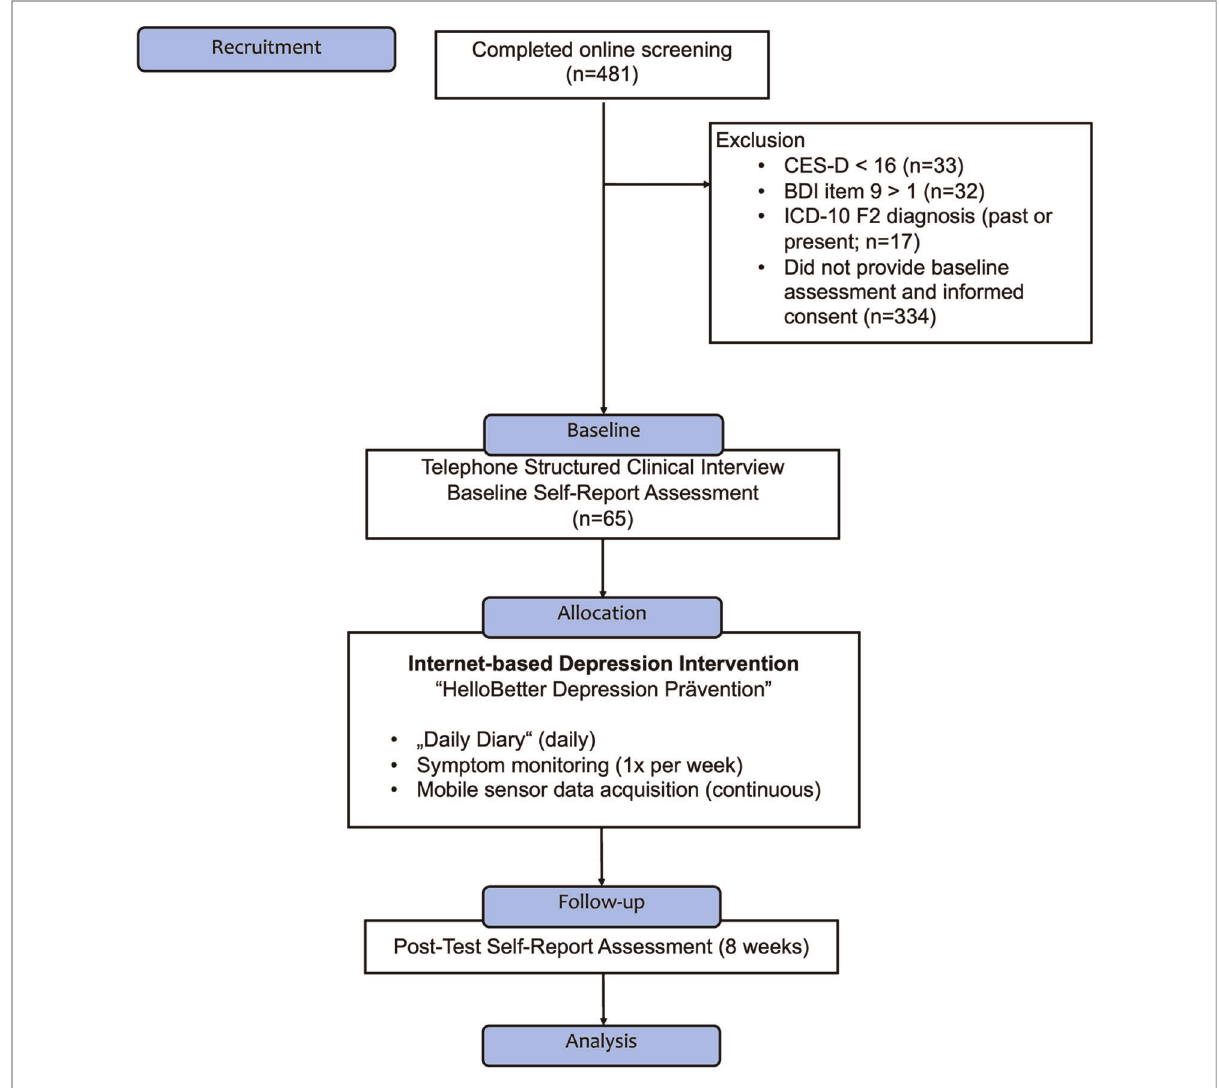
FIGURE 1 Flow diagram of the “ MAIKI ”